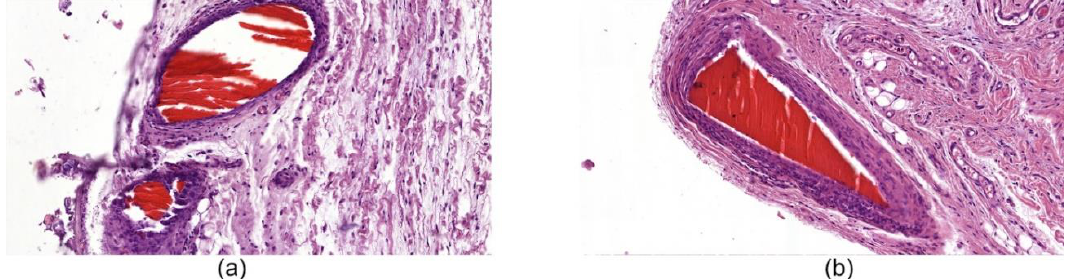
Figure 7. Histological microphotographs of biopsy samples of [chitosan + 0.5% ChNF] fibers, magnification 50×. ( a ) subfascial implantation, day 14; ( b ) subfascial implantation, day 91.